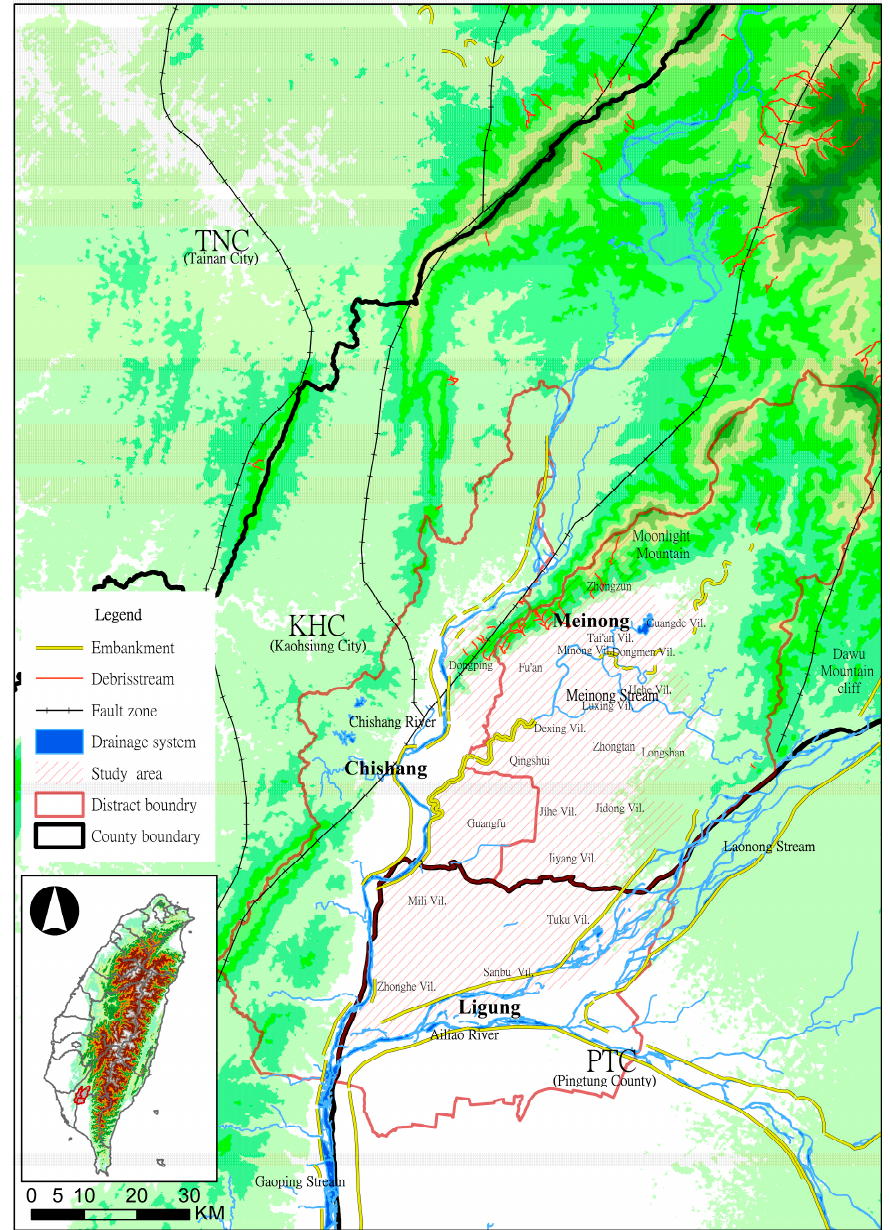
Figure 2. Study area: Meinong Plain, Taiwan. Table 1. Population and ethnic groups in the study